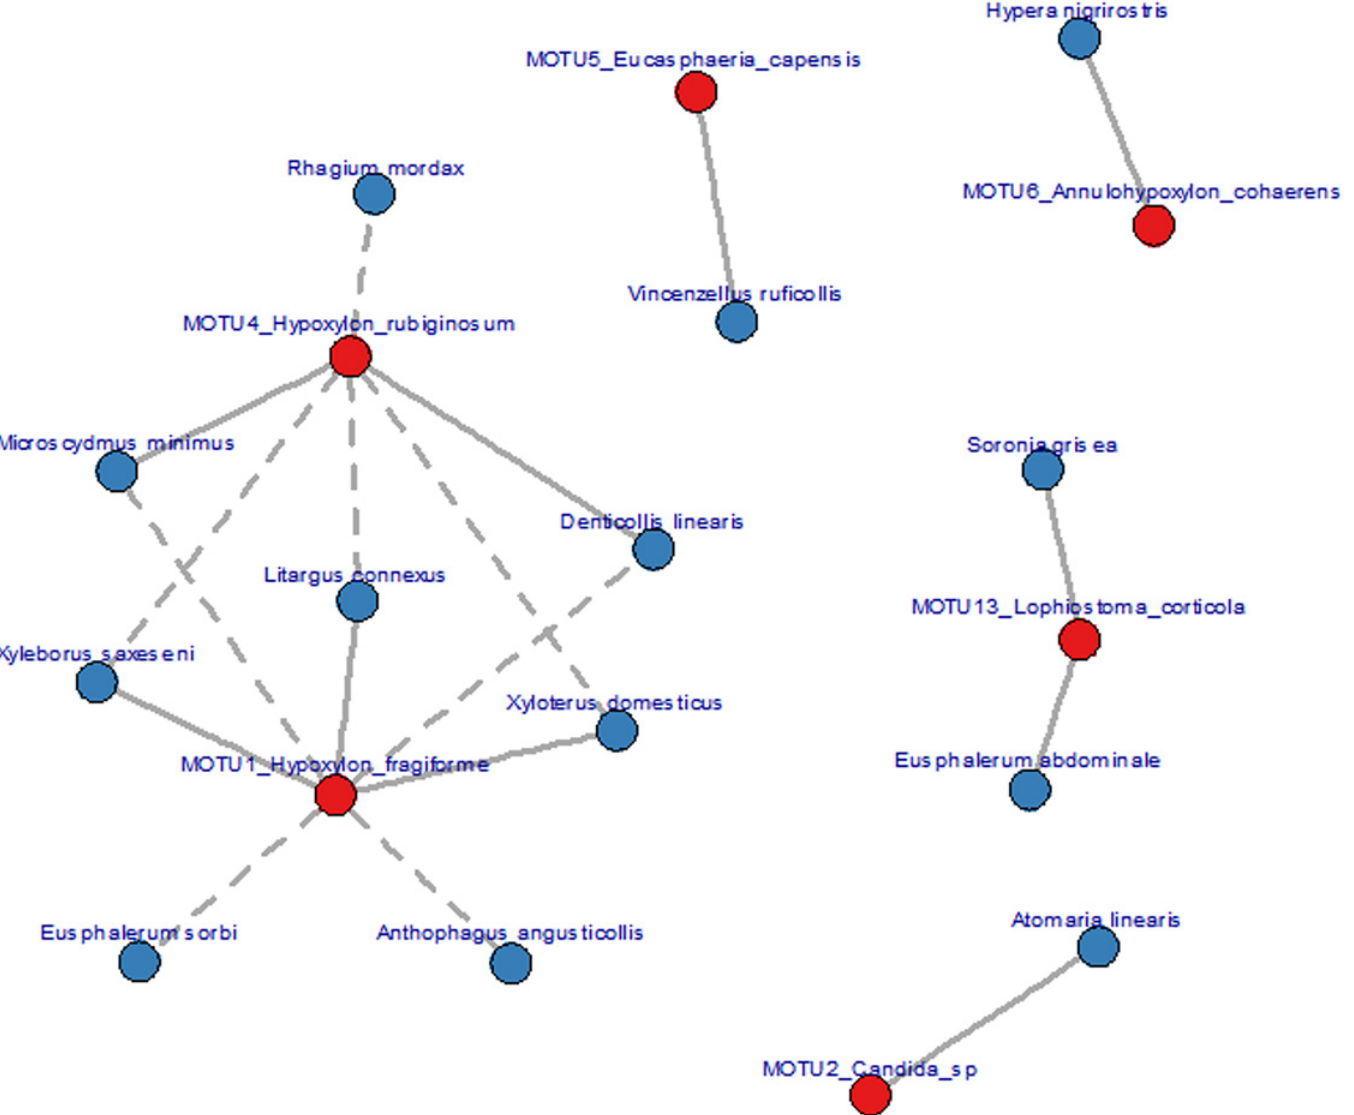
Fig 5. Graph visualising significant Spearman correlations (based on 10.000 random permutations) between fungi and beetles in the Hainich data. Solid lines represent positive correlations while dotted lines denote negative correlations. Fungi MOTUs are shown in red, beetle species in